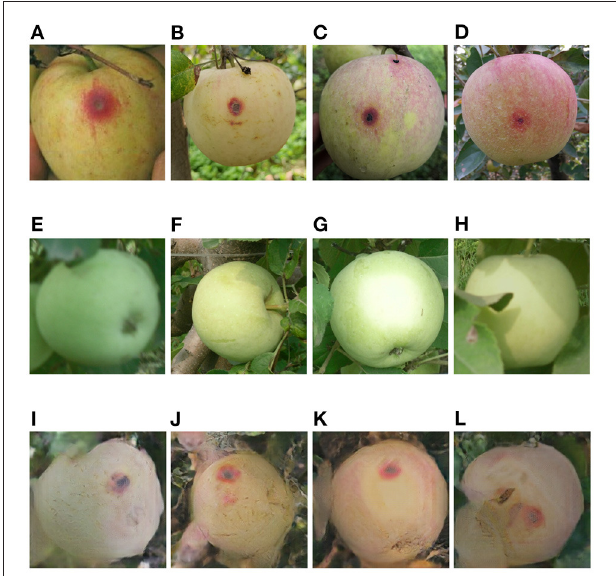
FIGURE 8 | (A–D) Serious anthracnose apple images captured in field, (E–H) healthy apple images, (I–L) serious anthracnose apple images converted from the above healthy apple images by the Cycle-GAN method.